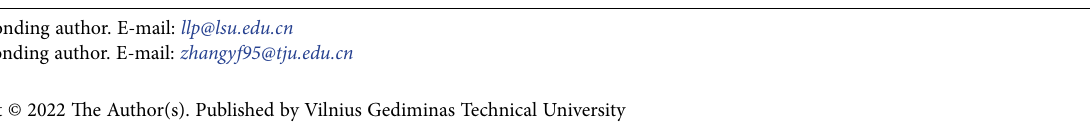
Figure 1. Structure diagram: a – base isolated structure; b – inter-story isolated structure; c – new staggered story isolated